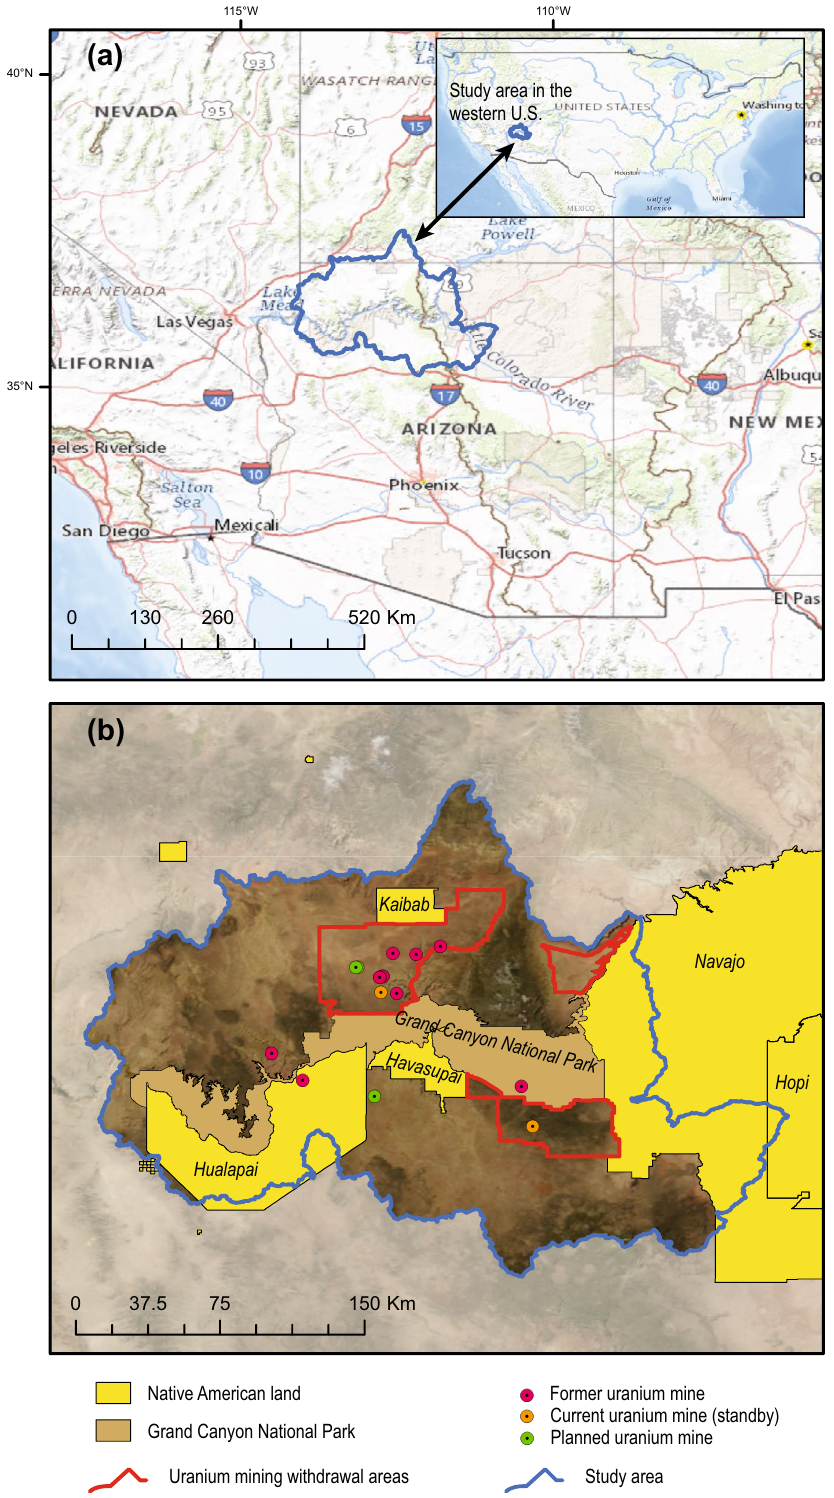
Figure 1. Map of study area within the western United States ( a ) and closeup of study area ( b ) showing locations of Tribal Nations, uranium mines, Grand Canyon National Park, and uranium mining withdrawal areas. Maps created in Esri ArcMap 10.8.1 (https:// www. esri. com/). Basemap images from the public domain USGS National Map 11